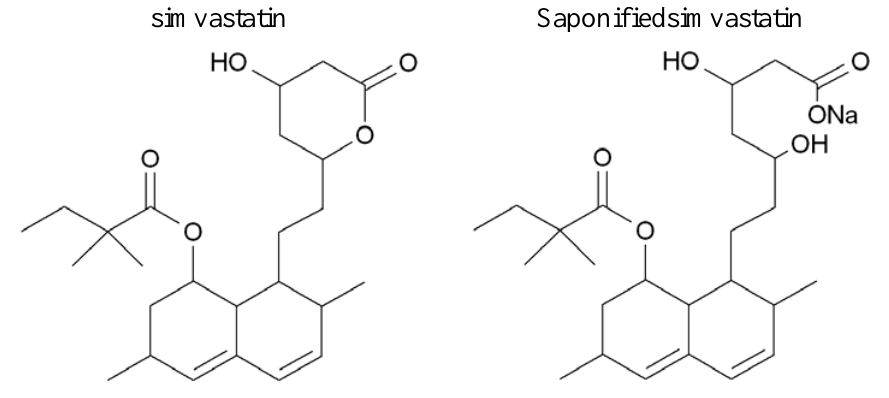
Figure 1. Chemical structure of simvastatin with the closedlactone ring prior to- and open lactone ring after the process of